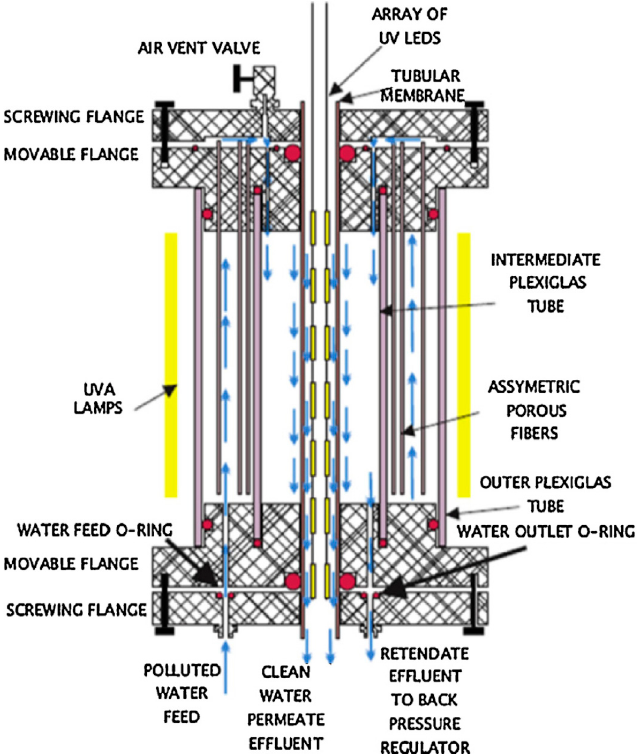
Figure 4. Schematization of the hybrid experimental set-up used by Papageorgiou et al.